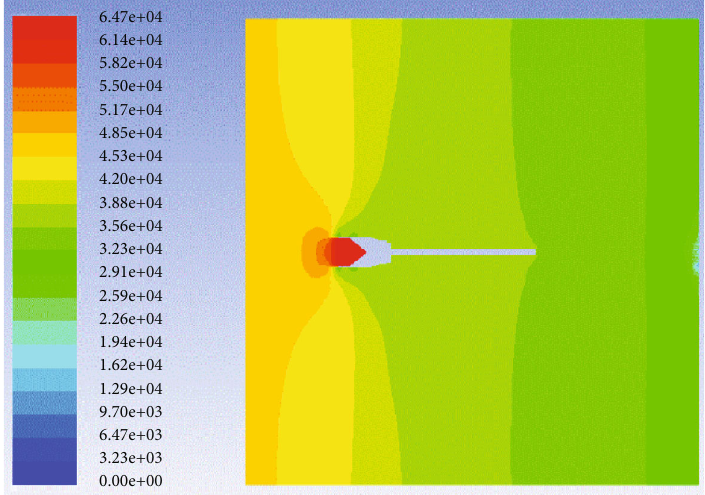
Figure 11: Pressure contour when v = 40 m / s , α = 0 ∘